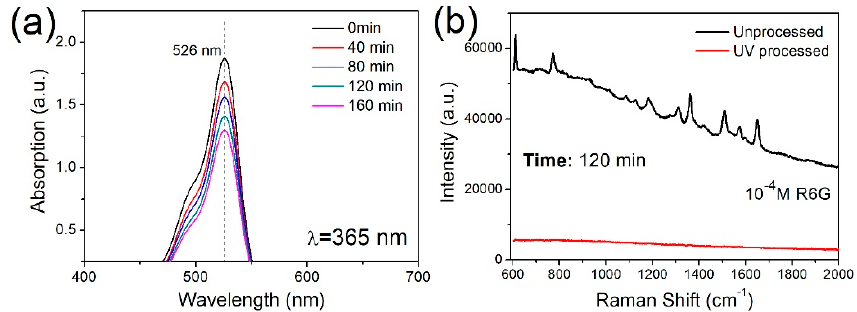
Figure 6. ( a ) UV-Vis absorption spectra of R6G solutions following UV irradiation with different times on the surface of Ag nanoparticle-coated silicon nanowire array. ( b ) Raman spectra of 10 − 4 M R6G solution before (black) and after (red) 120 min UV photocatalytic degradation.